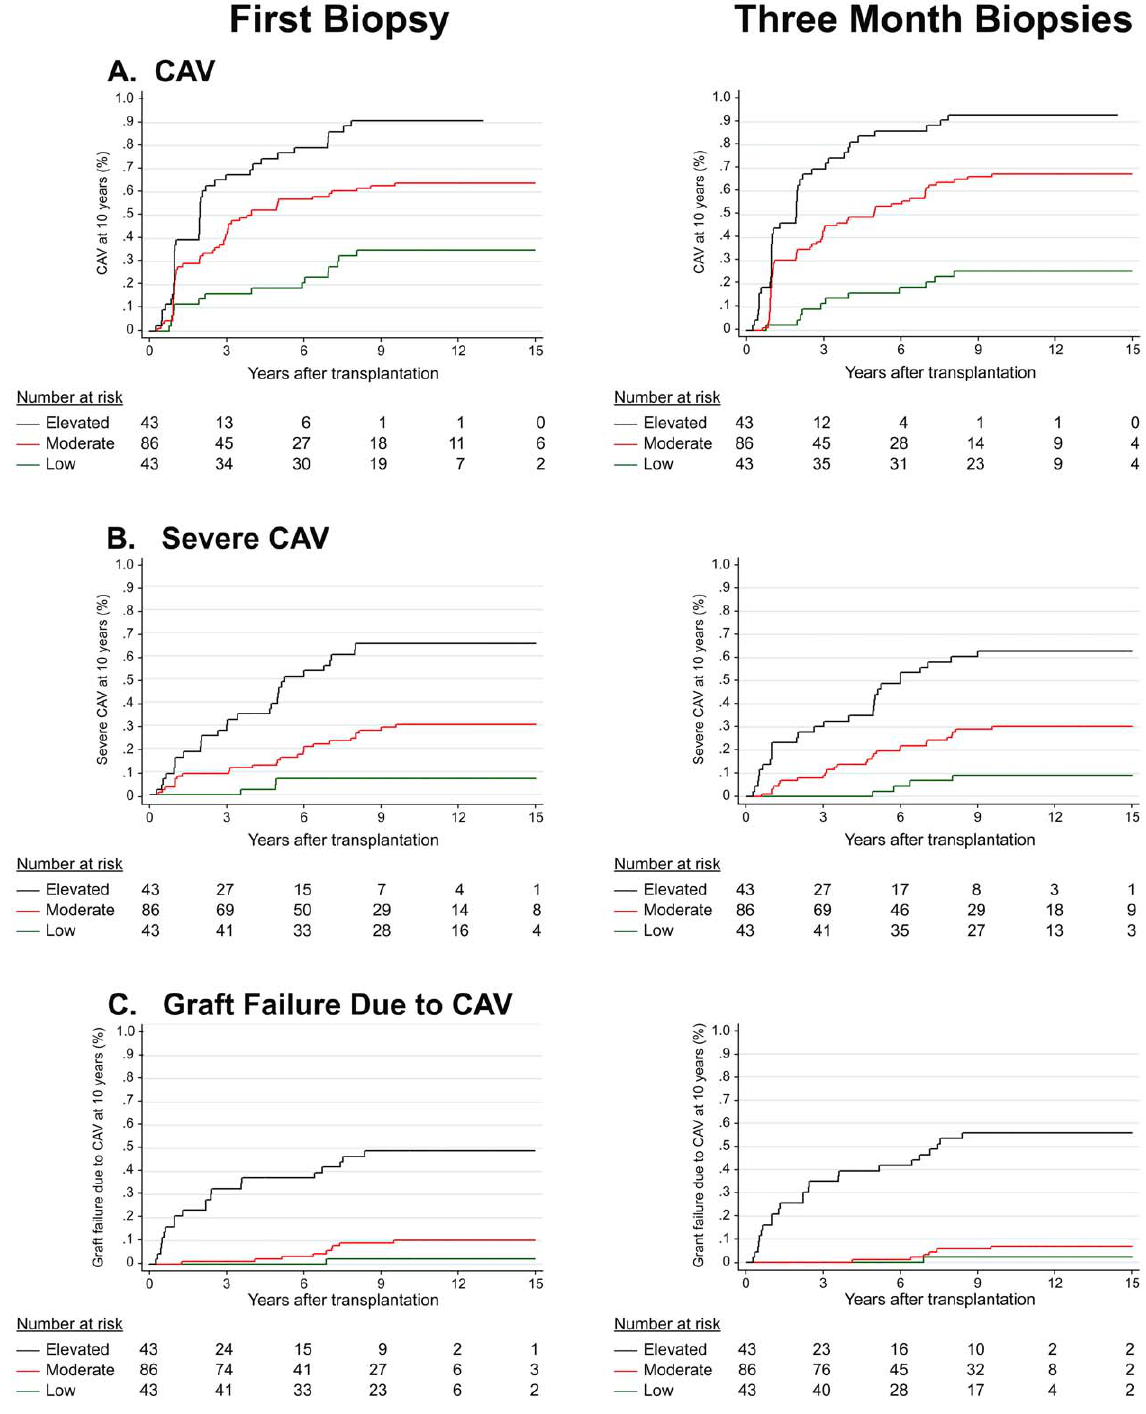
Figure 2. Kaplan-Meier curves using 10-year regression models. Kaplan-Meier curves of risk-stratified groupings derived from first-biopsy versus three-month biopsy models showing time to (a) CAV, (b) severe CAV, and (c) failure due to CAV. Risk groupings were formed from the distributions of the predictive probabilities from 10-year logistic regression models (low risk=lower 25%, moderate risk=middle 50%, and high risk=upper 25%).